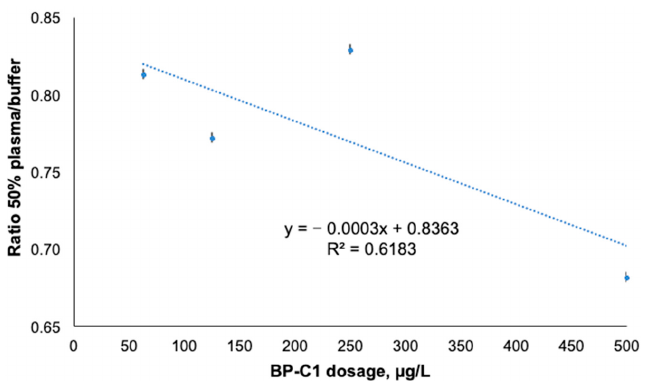
Figure 3. Ratio of 50% plasma to control buffer for the dialysed fraction of platinum (Pt), indicating plasma protein binding. Plasma and control buffer were dialysed against PBS with pH 7.2 for 4 h at 37 °C across the 8 kDa cut-off vertical membrane. Pt was quantified by ICP-MS after microwave digestion. Dashed line represents linear trend. Error bars represent ± standard deviation ( n = 6).